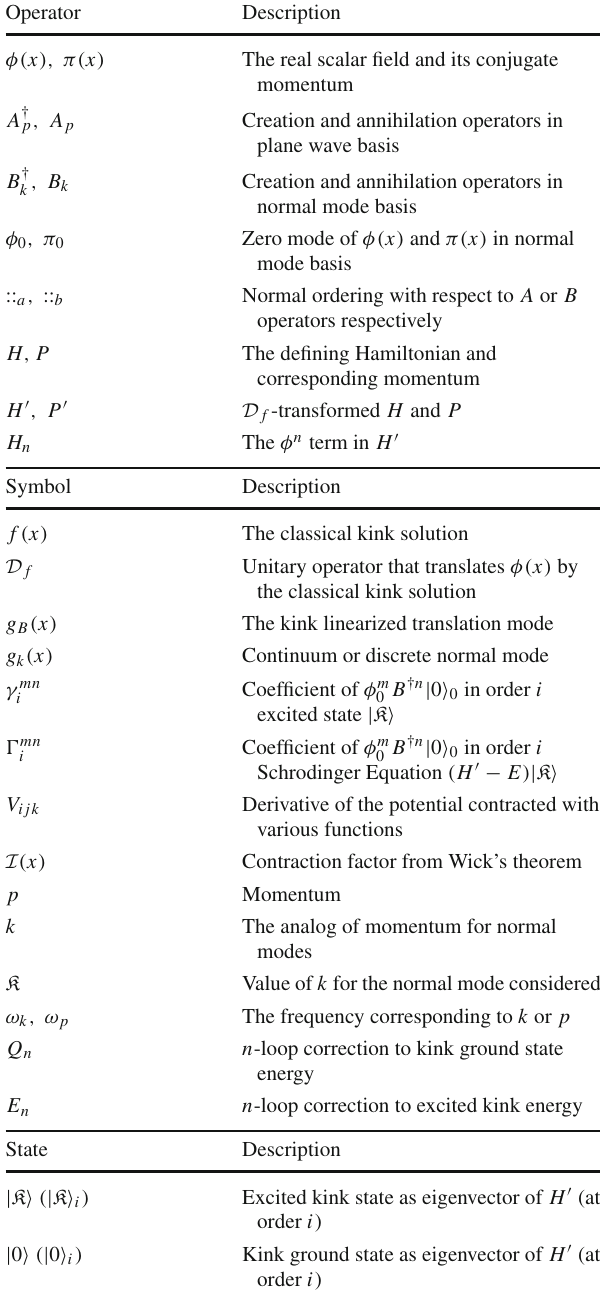
Table 1 Summary of